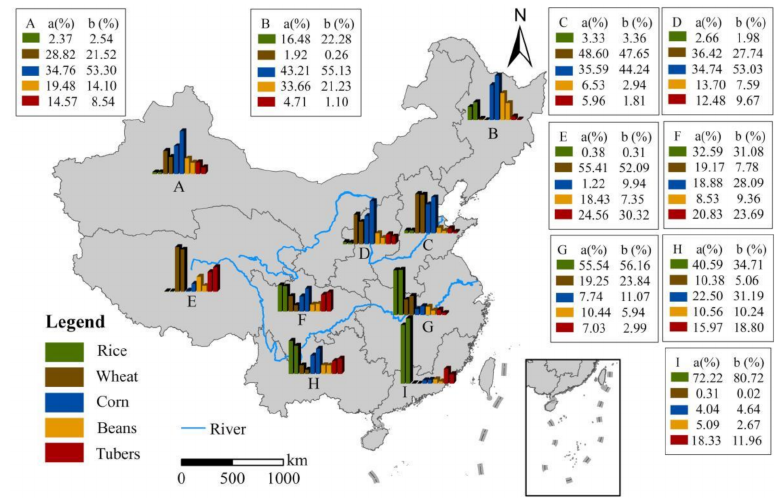
Figure 4. Changes of grain planting structure of China’s nine agricultural regions in 2003 and 2019. ( A – I ) represents each agricultural regions, ( A , B ) refer to 2003 and 2019, respectively. The values are the planting structure of different food